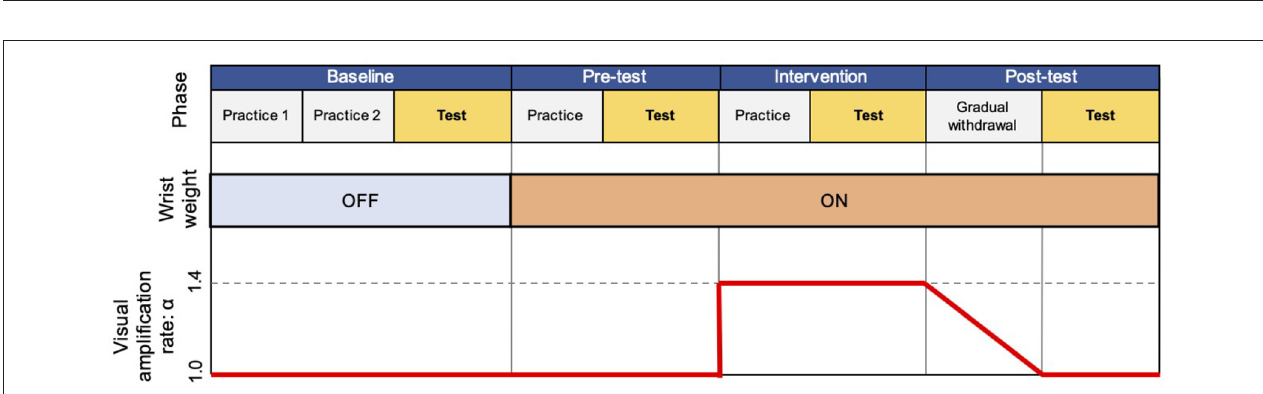
FIGURE 3 | Flow of experiment. The experiment consisted of four experimental phases (baseline, pre-test, intervention, and post-test), each of which includes practice or gradual withdrawal session, and a test session.